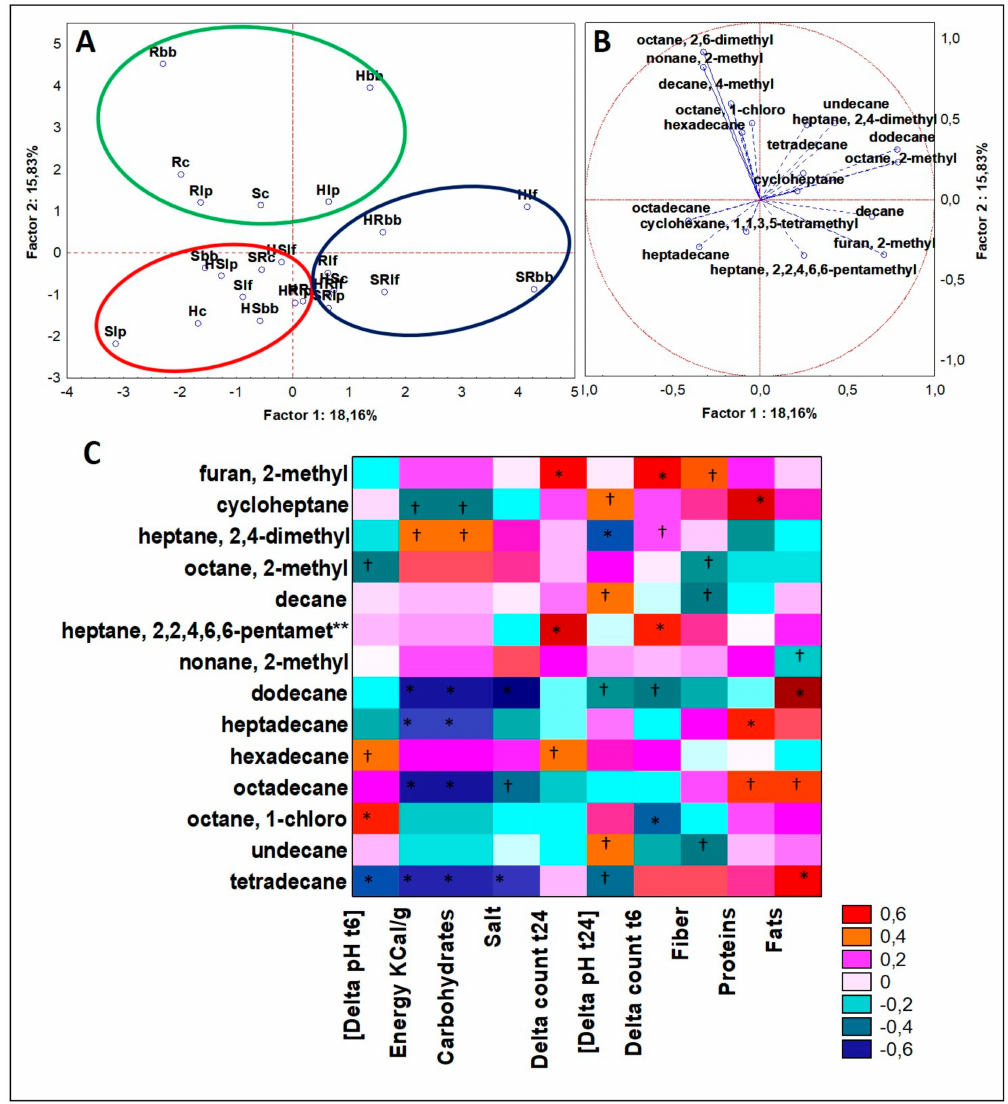
Figure 6. ( A ) PCA of cases and ( B ) variables on alkanes; ( C ) Spearman rank correlations on alkanes. * p < 0.01; † p < 0.05. **heptane,2,2,4,6,6-pentamethyl. For samples abbreviations see Figure 1. Figure 6A: cluster 1 = blue line; cluster 2 = red line; cluster 3 = green line.3.4.5. Organic